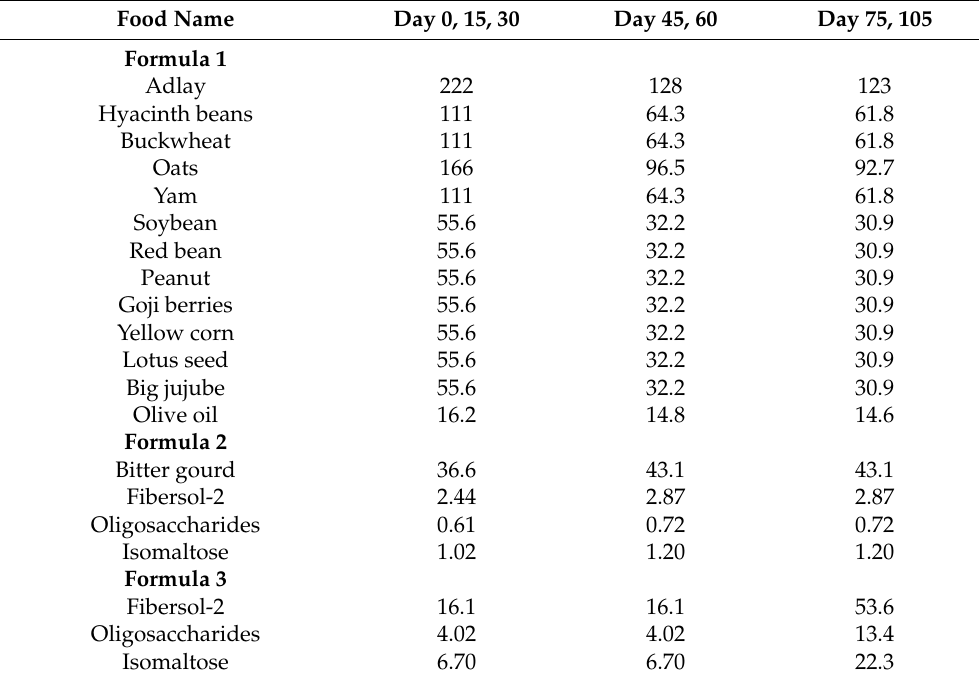
Table 1. Food intakes on different sampling days